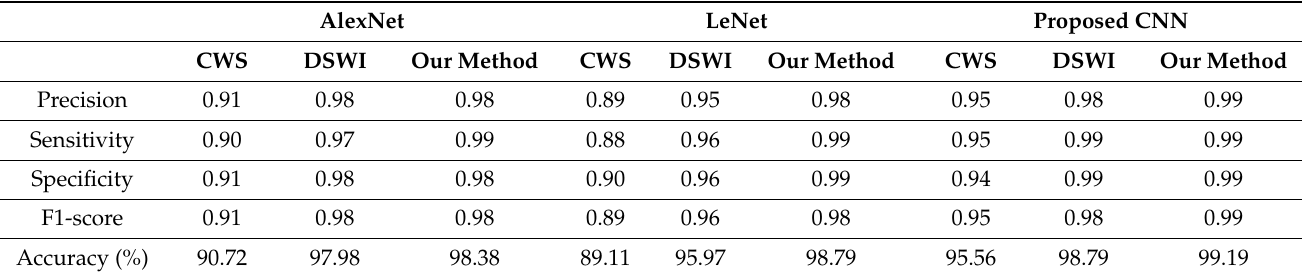
Table 3. The evaluation parameters for different CNN